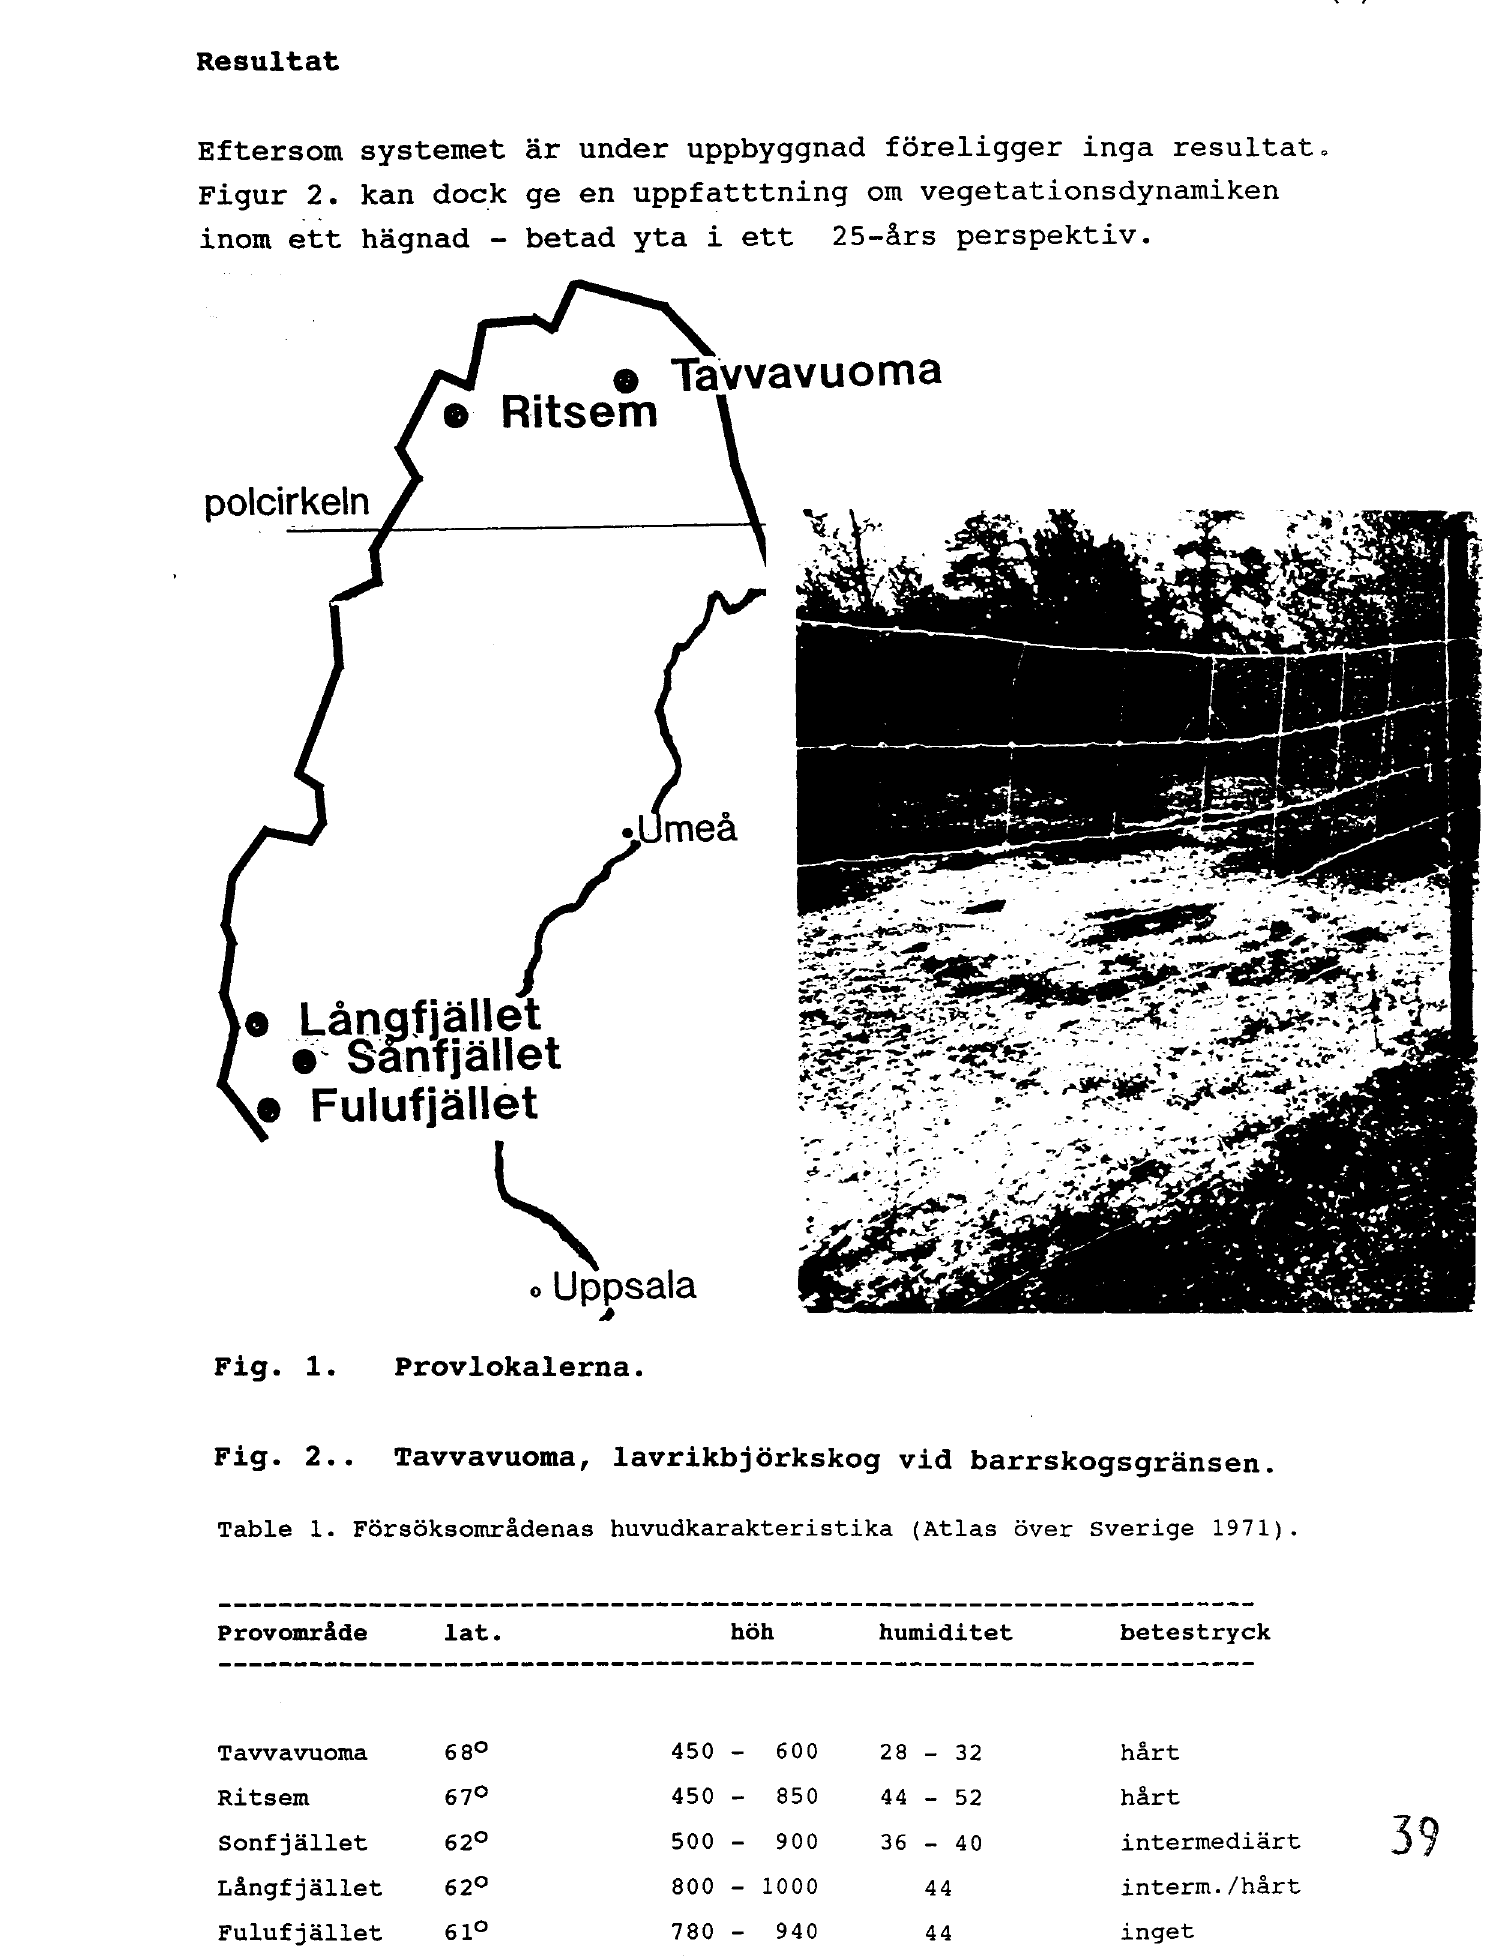
Provområde l a t.